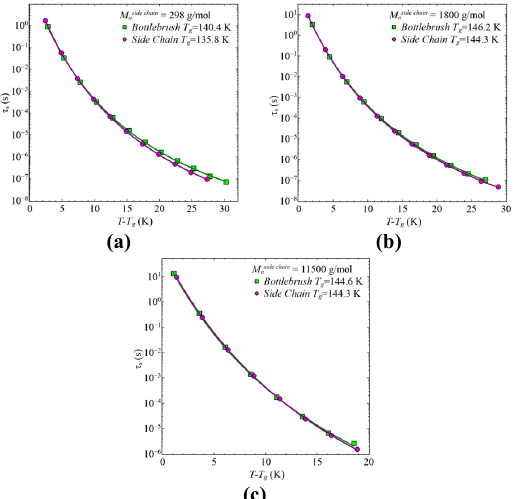
(c) Fig. 7. Segmental relaxation time, 𝜏 (cid:3046) , as a function of 𝑇 (cid:3398) 𝑇 (cid:3034) for each bottlebrush polymer in comparison with their respective single linear side chain. (a) Sample 1, (b) Sample 2, and (c) Sample 3. Solid lines are the best description with the VFT